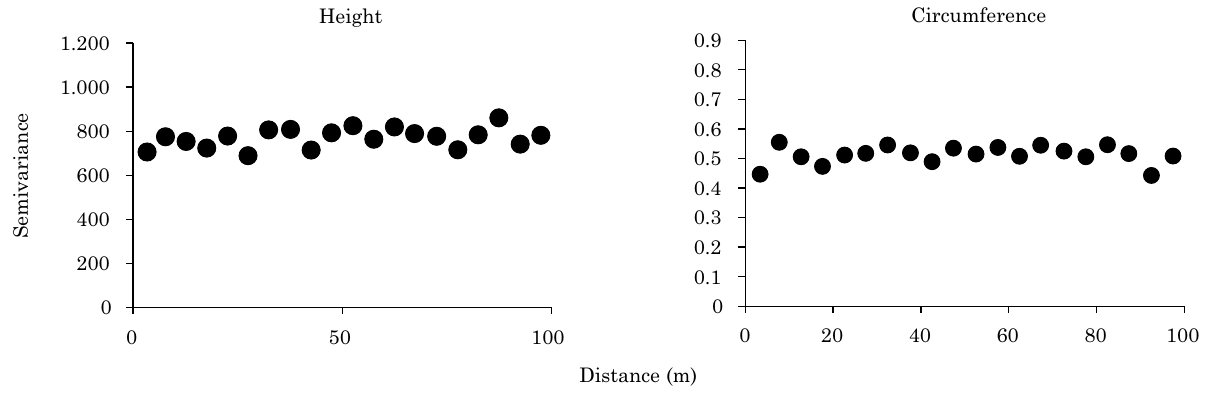
Figure 2. Semivariogram of termite nest circumference and height evaluated in Plot 3 from Pasture 2, on the Fazenda Campana, Rio Brilhante,